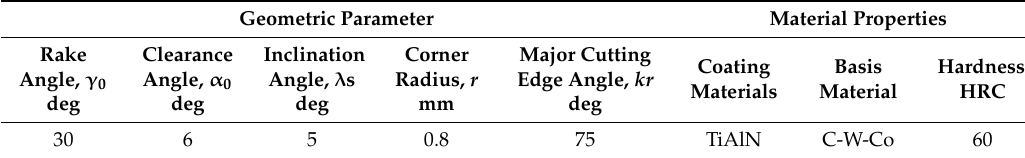
Table 2. Parameters of the cutting tool.